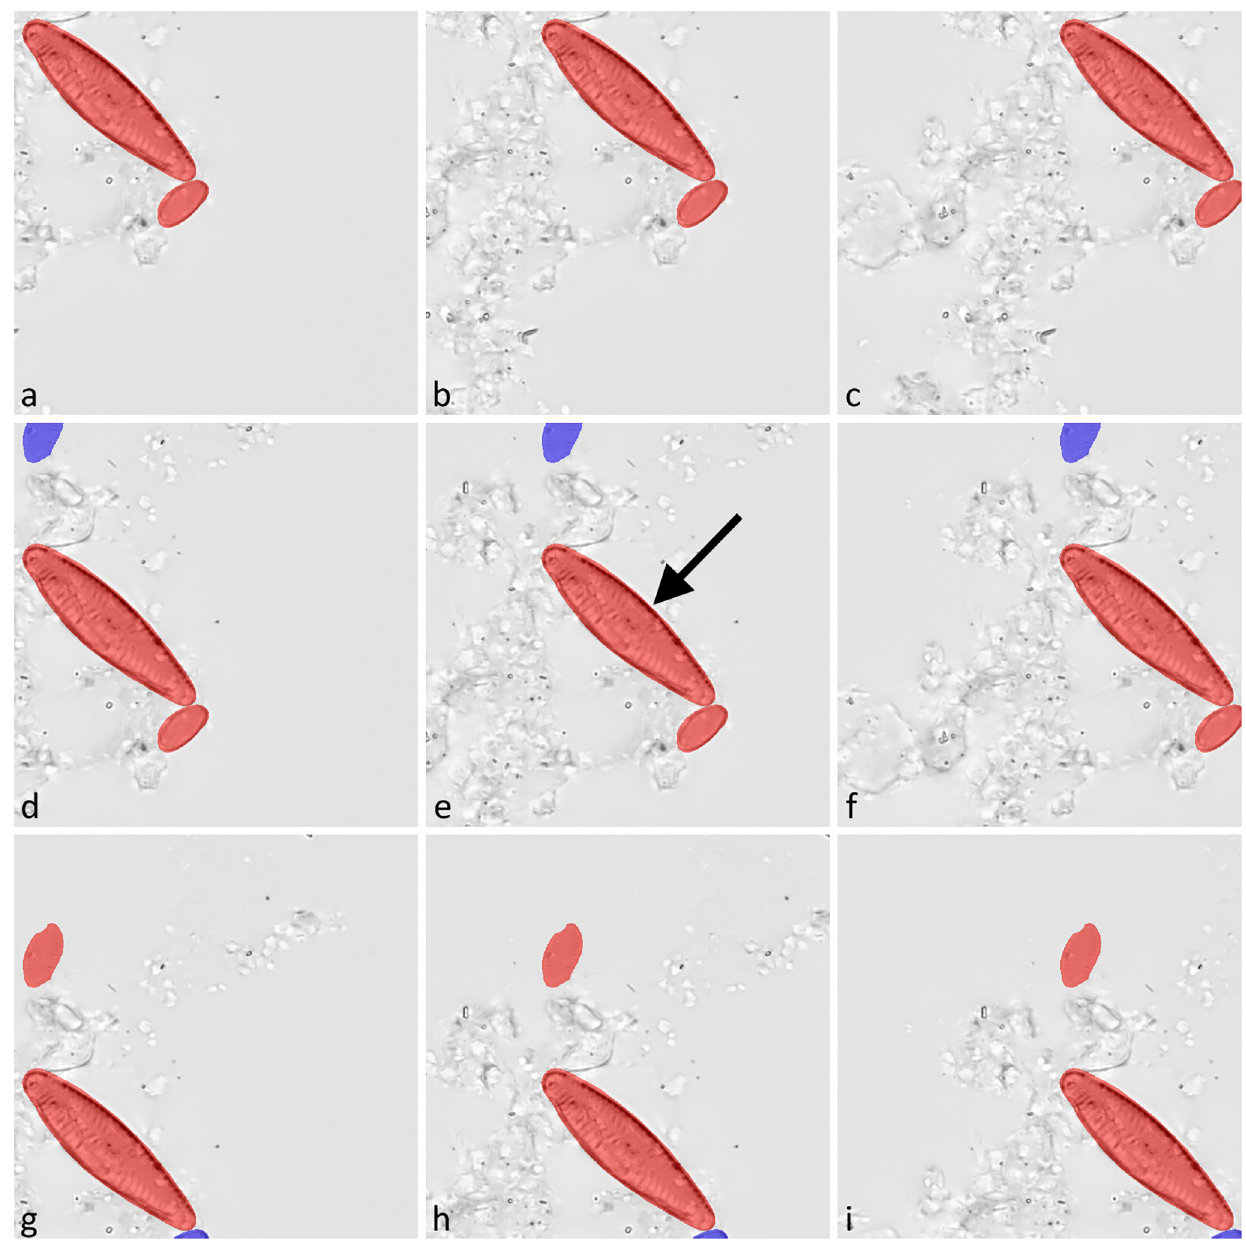
Fig 5. Training data tiles generated by the two object-based positioning methods for one specific diatom object (marked with an arrow in e). The two smaller diatom objects were contained coincidentally due to their close proximity. For each annotated object, nine tiles were created (a-i). Object-based positioning alone incorporated all objects in the segmentation mask (red and purple highlights). Contrasting this, object-based positioning + object integrity constraint excluded neighboring objects from a tile’s segmentation mask if they were contained by less than 75% within that tile (d-i, purple